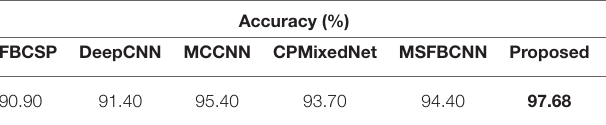
TABLE 7 | Intra-subject classification results using high gamma dataset